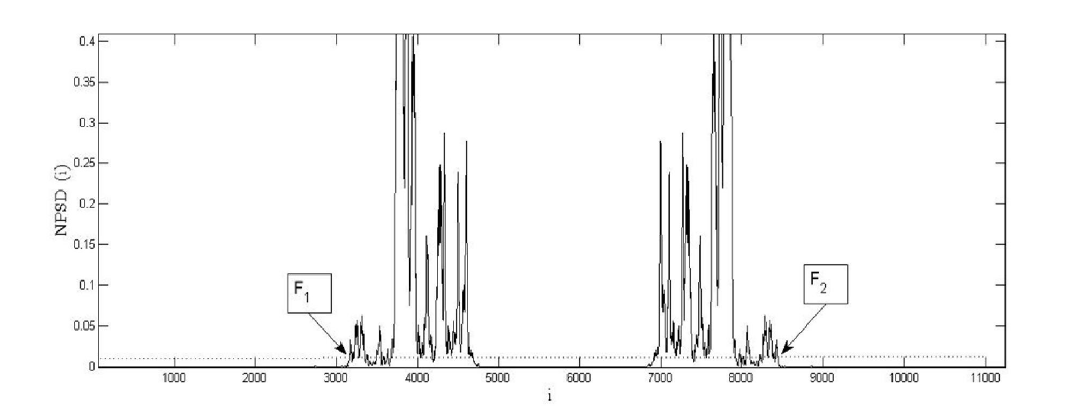
Figure 4. Example of the effective frequency band of the cross-phase spectrum of the compared signals. Dashed line denotes the proposed threshold ( thr p ).